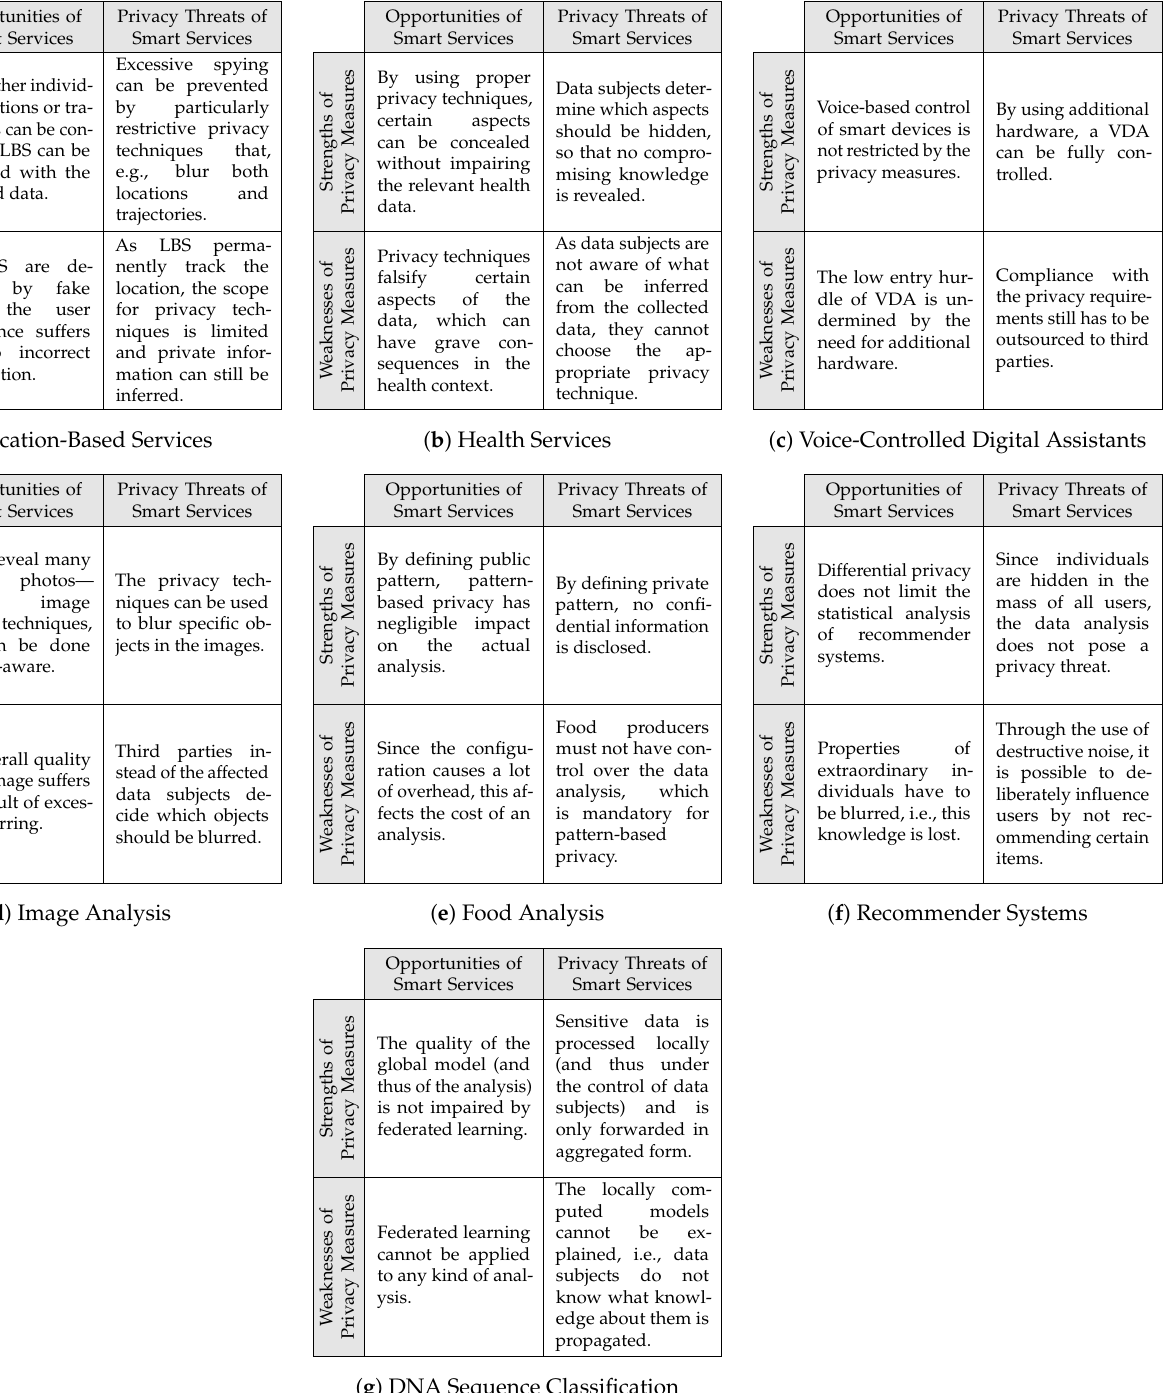
Figure 16. Results of our SWOT Analysis Broken Down by the Respective Application